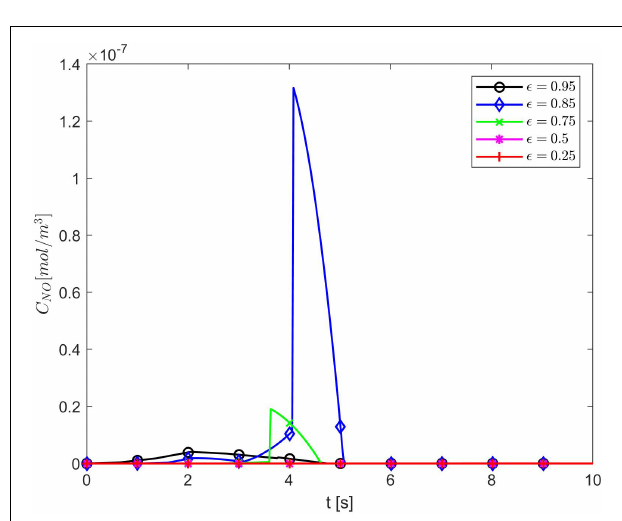
FIGURE 5 | Temporal profiles of C NO at r = a + h , the outer boundary of the endothelium, for p = 1 ( q = 0 ) and various values of ε . Here E = 6 × 10 3 N / m , γ = 0 . 75 , ˜ λ = 6 . 5325 × 10 3 s − 1 .